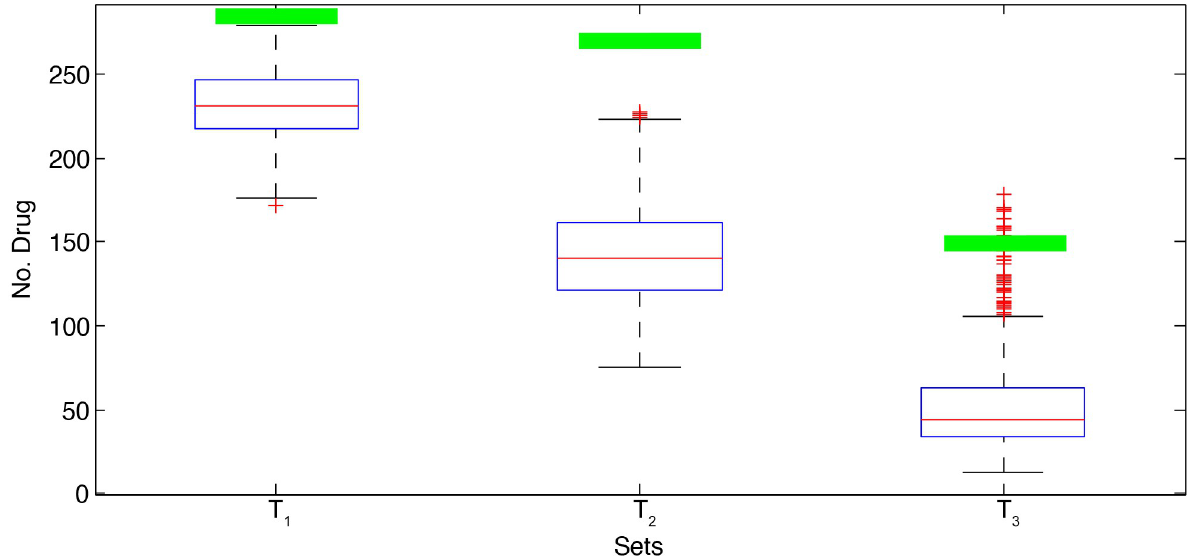
Fig 3. The boxplot of the results of the random sets for Clinical-Drug.